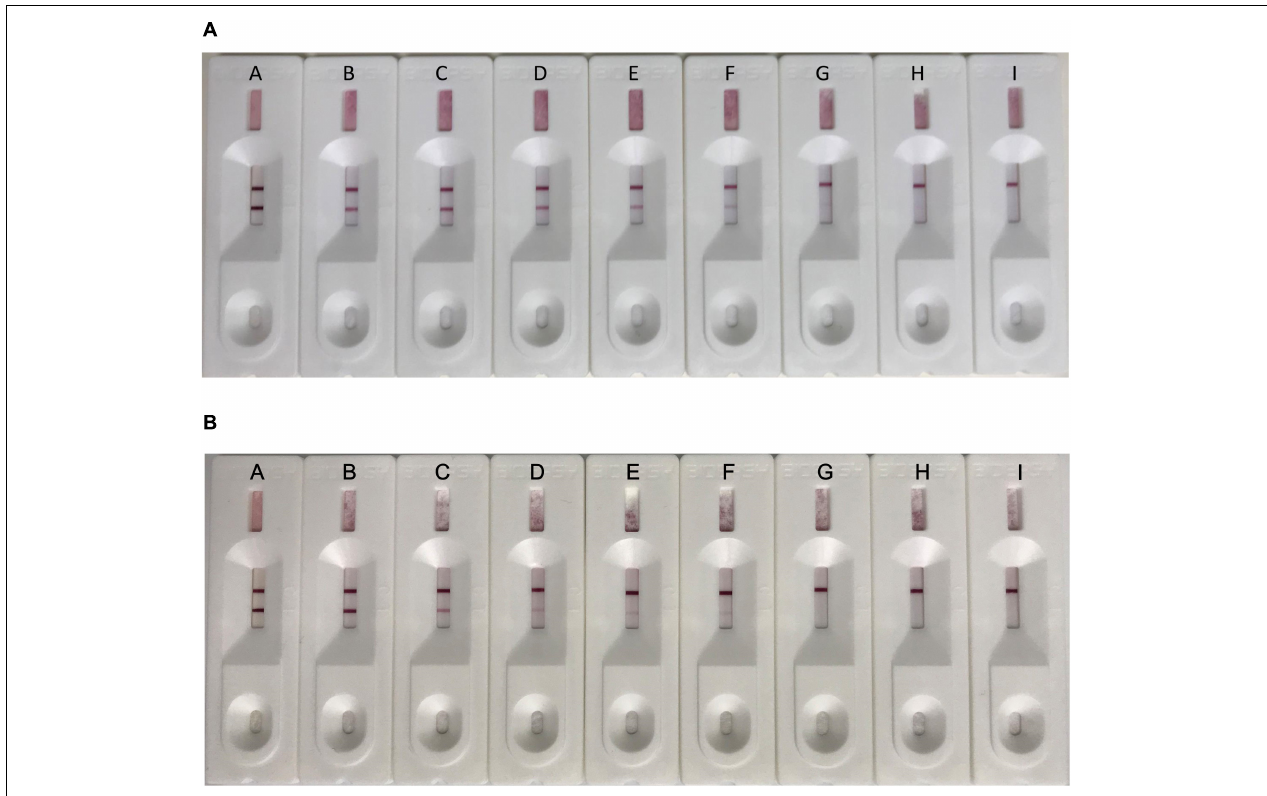
FIGURE 5 | Sensitivity testing of the ICS. Serial dilutions of CAdV-2 were prepared in sample buffer (A) or negative dog serum (B) and tested using the ICS assay developed in this study. Dilutions of virus tested contained (A) 5 × 10 5 TCID 50 /ml, (B) 5 × 10 4 TCID 50 /ml, (C) 5 × 10 3 TCID 50 /ml, (D) 2.5 × 10 3 TCID 50 /ml,